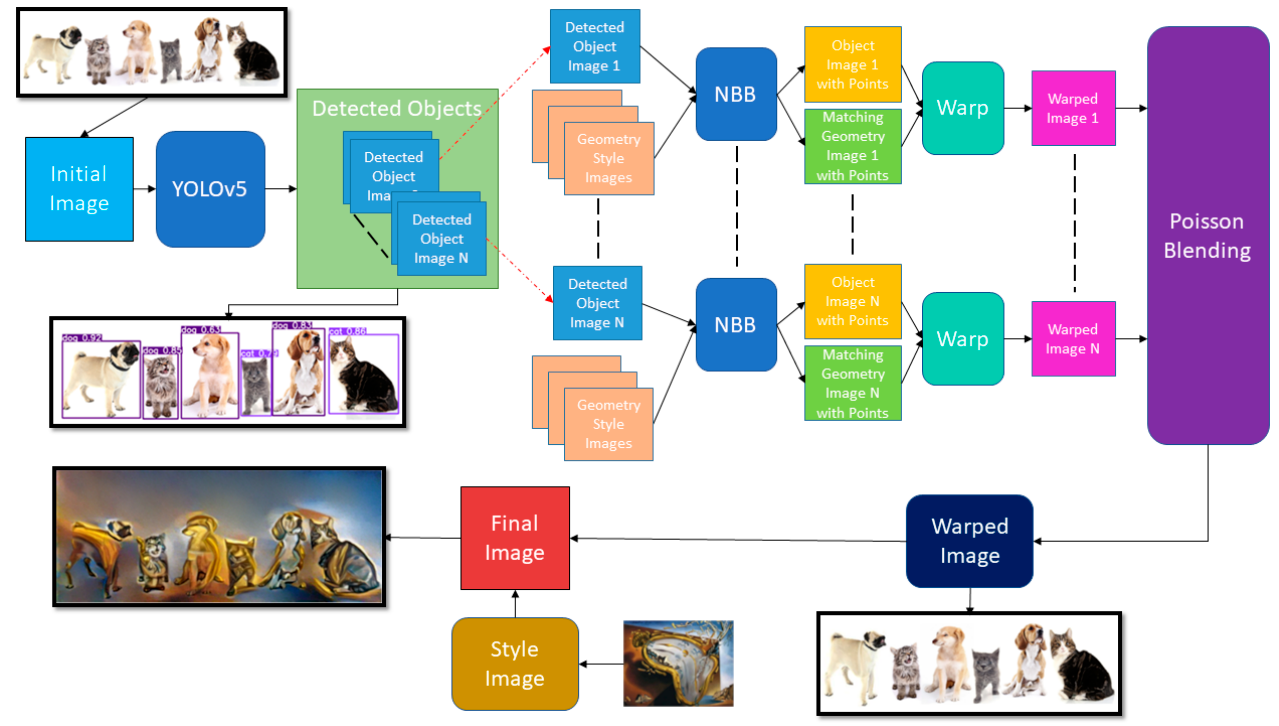
Figure 2. Overview of our proposed solution.